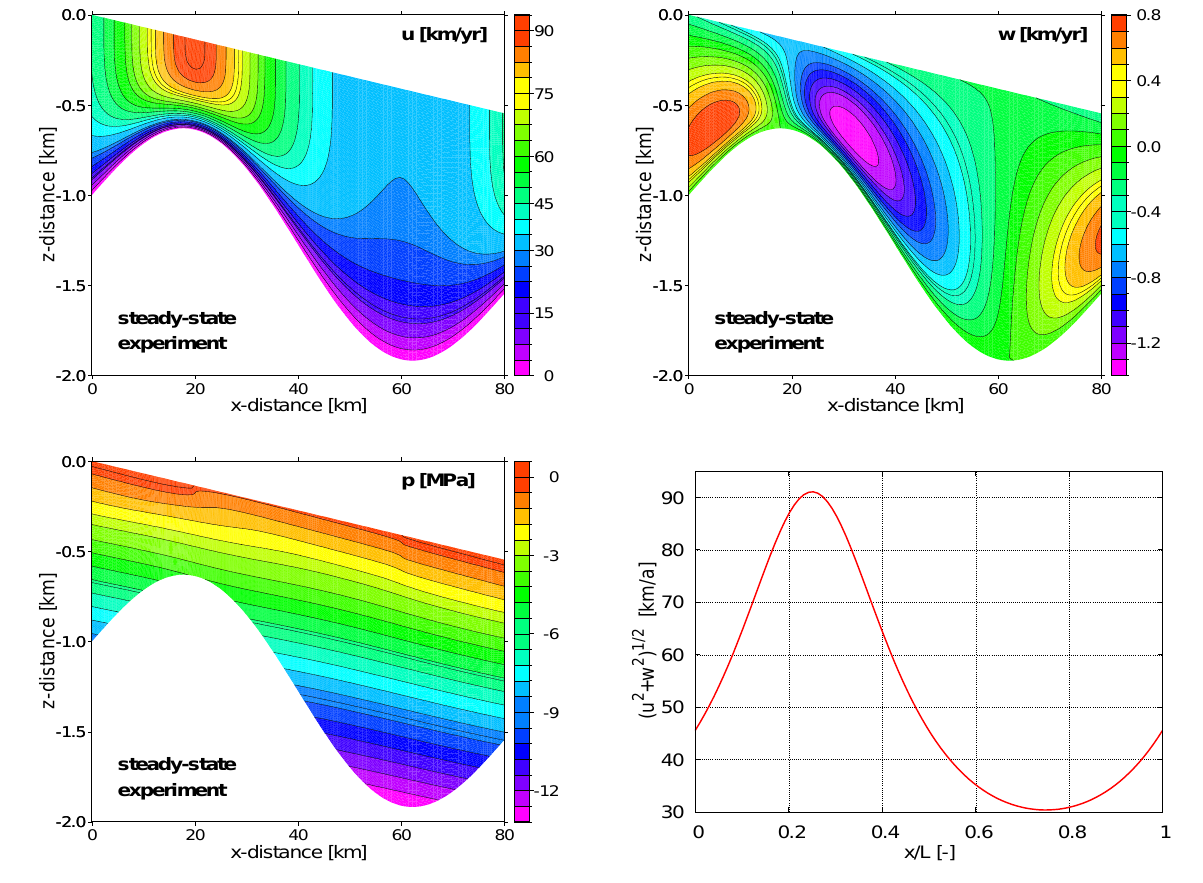
Fig. 5. 2-D flowline steady-state experiment - version of experiment B from (Pattyn et al., 2008) (flow with a linear sloping surface and a sinusoidal frozen bed); the graphs show horizontal u and vertical w velocity in [km/yr], the ice pressure in [MPa] and the norm of the (cid:16) (cid:17) 1 / 2 u 2 + w 2 surface velocity in [km/yr]. The horizontal velocity is anti-correlated with the ice thickness. Pressure is proportional to the ice thickness. The norm of the surface velocity is larger over the bump and smaller over the trough. This is consistent with the observation that in 2-D flowline experiments the ice cannot flow around the